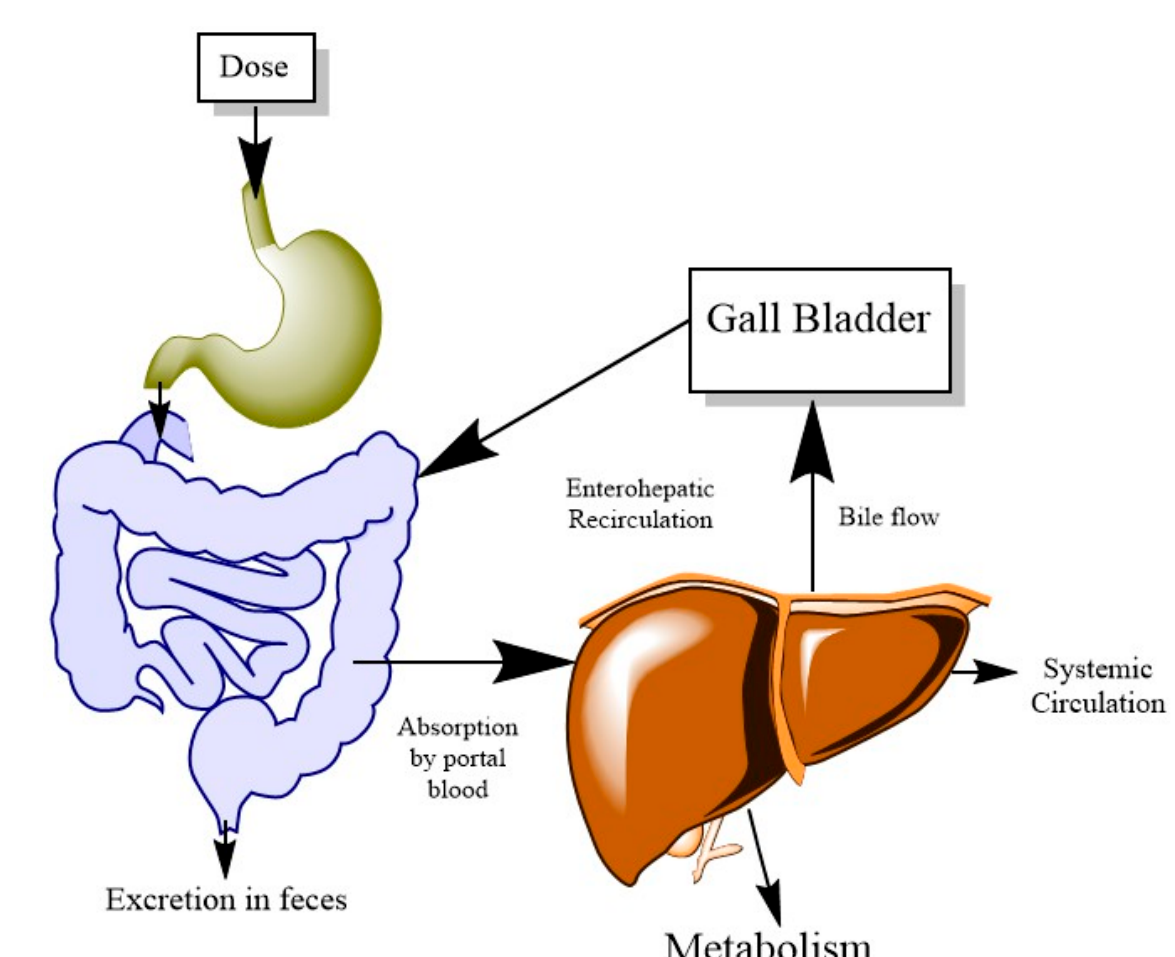
Figure 4. Oral absorption of xenobiotic followed by enterohepatic recirculation (EHR). EHR occurs by biliary excretion followed by intestinal reabsorption of xenobiotic along with hepatic conjugation and intestinal deconjugation.